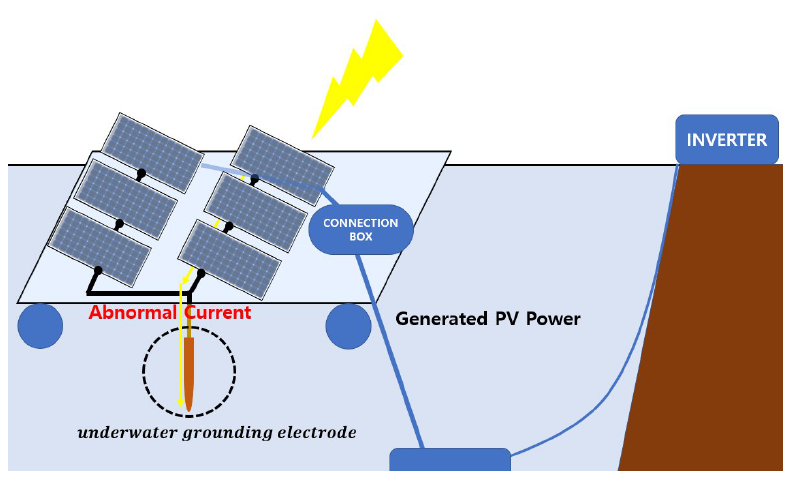
Figure 1. Schematic diagram of the underwater grounding electrode array for the floating PV